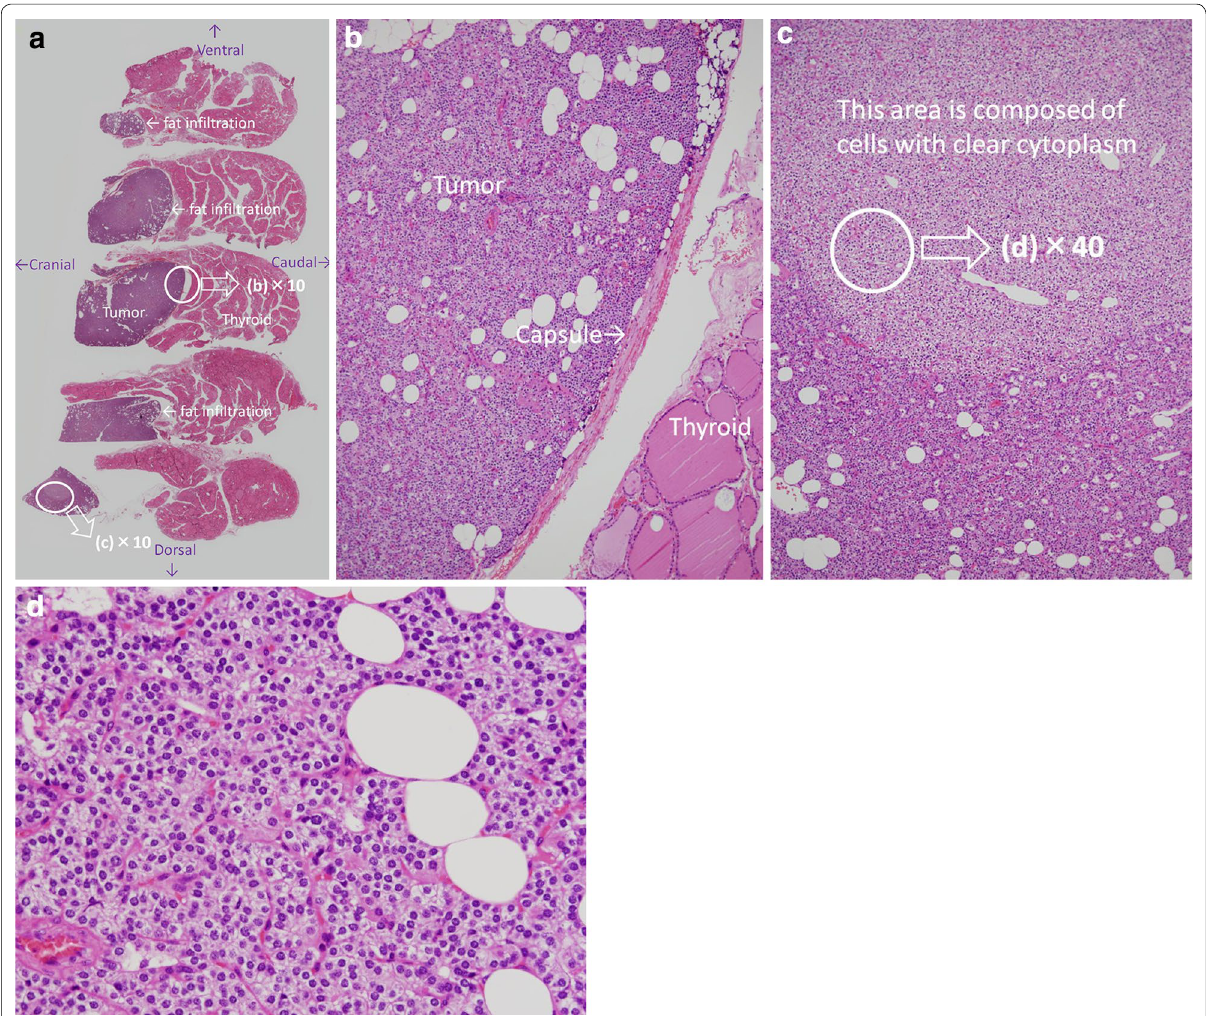
Fig. 4 Pathological findings (Hematoxylin and Eosin stain) a Semi-macroscopic view (loupe image). The longitudinal images of the tumor are arranged in order. b 10. The parathyroid adenoma was surrounded by a thin fibrotic capsule. c × composed of cells with clear cytoplasm, and there was scattered fatty infiltration. d was almost uniform throughout. There was no evidence of